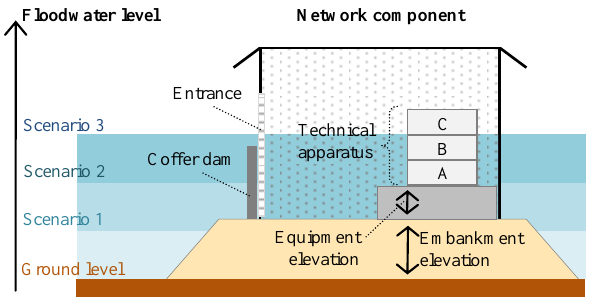
Fig. 3. Flood vulnerability indicators for consideration in the anal- Figure 3. Flood vulnerability indicators to consider in the analysis of network components 2 ysis of network component susceptibility to damage and dysfunc- susceptibility to suffer damage and dysfunctions due to direct contact with floodwater. 3 tions due to direct contact with